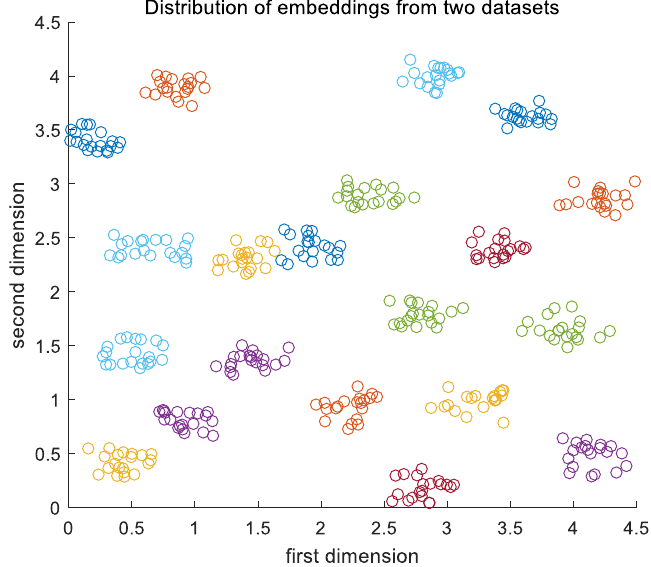
Figure 16. The distribution of embeddings from new and old tasks.